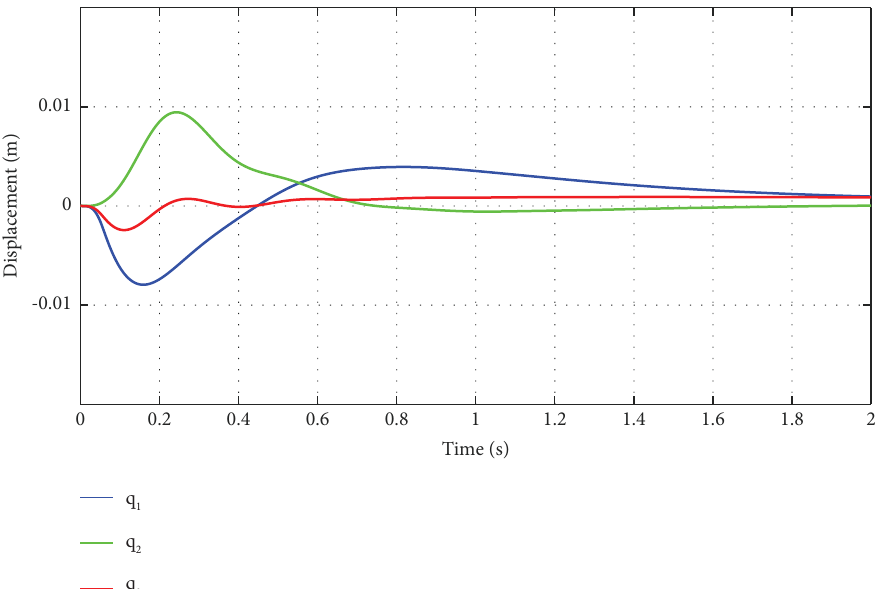
Figure 4: Displacements of parts of the mobile antiaircraft weapon system after launch at the angle of attack α placement of unsprung mass m 1 of the front suspension, q 2 -vertical displacement of unsprung mass m 2 of the rear suspension, and q 3 - vertical displacement of mass center of the vehicle’s body.